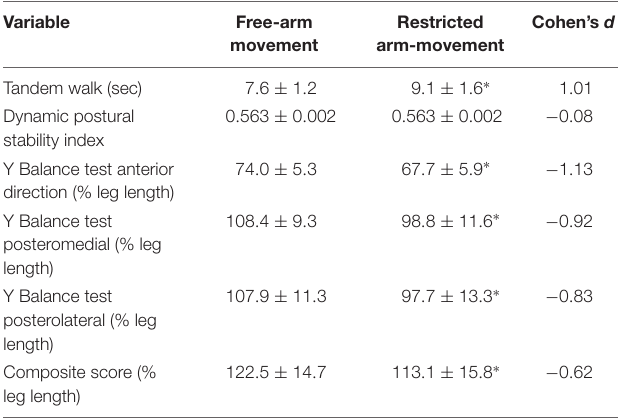
TABLE 1 | Mean ± SD and Cohen’s d effects size for the difference in dynamic balance performance between free and restricted arm movement conditions.